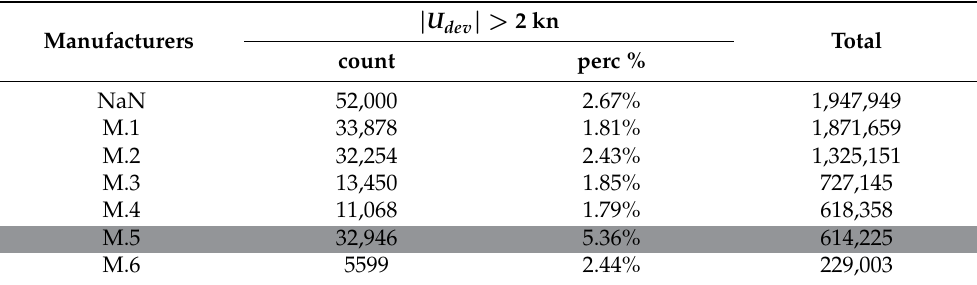
Table 10. Speed deviation U dev above 2 kn boundary decomposed by DVL manufacturer installed on the 190 ships of this study. Gray background occurs when | U dev | > 2 kn percentage column is greater than 2.47%.